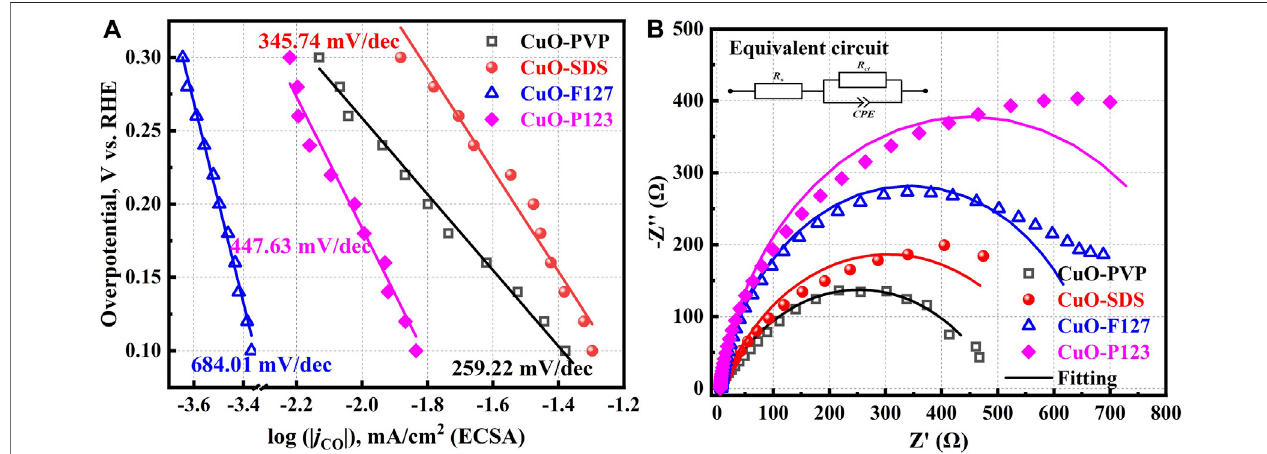
FIGURE 7 | FE CO and total current densities of the different catalysts reported in literatures for ECR to CO.